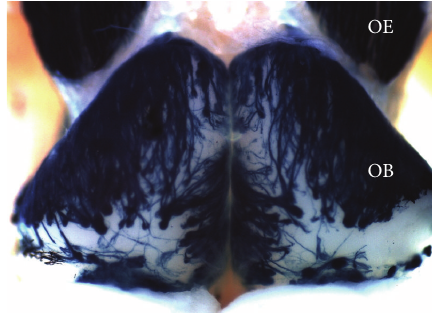
Figure 1: The glomerular map in the OB. OSNs in the OE project their axons to form glomeruli on the surface of the OB. The dorsal view of the OB of an OMP- (olfactory marker protein-) tau-LacZ mouse is shown. Beta-galactosidase (blue) activity was revealed by